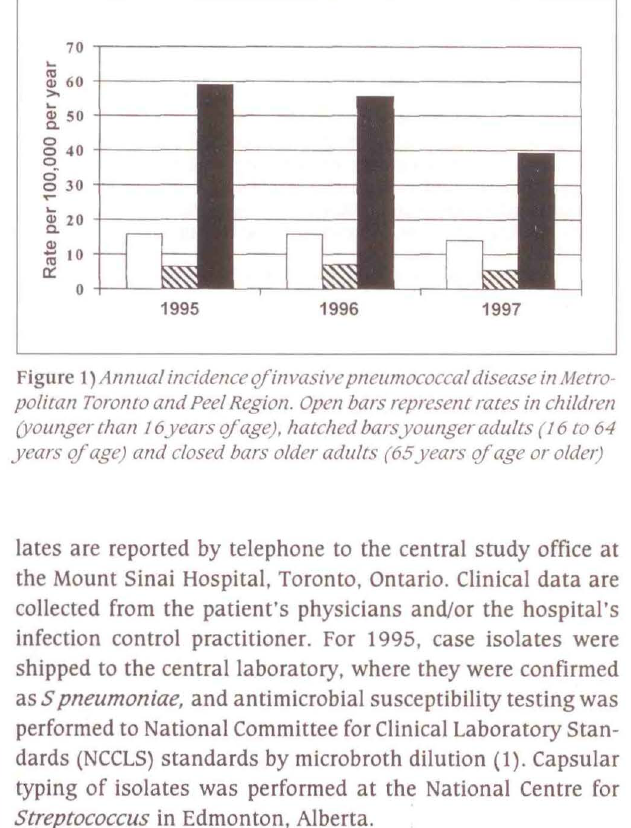
Risk of invasive pneumococcal disease in adults